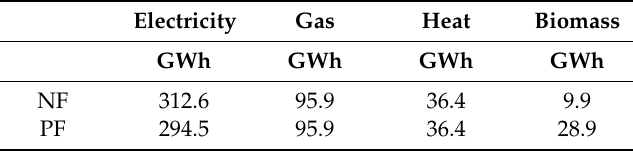
Table 11. CExC for the imported energy